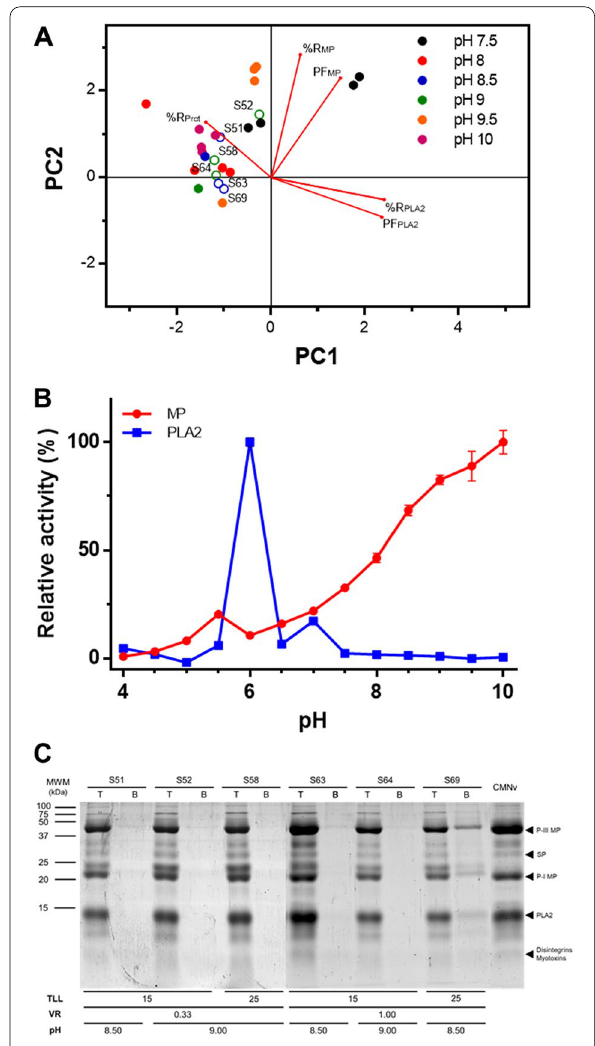
Fig. 3 Effect of pH on the recovery of MPs and PLA 2 in PEG–salt systems. A Principal component analysis (PCA) analysis of the recovery of MPs and PLA 2 in selected systems at different pH values (7.5–10). Clear circles ( ○ ) denote the selected ATPS with the best partition characteristics. B Effect of pH on MPs and PLA 2 activities. C SDS‑PAGE of top and bottom phases (T and B, respectively) of selected ATPS from PCA analysis, 15 μg of C. m. nigrescens venom (CMNv) and molecular weight marker